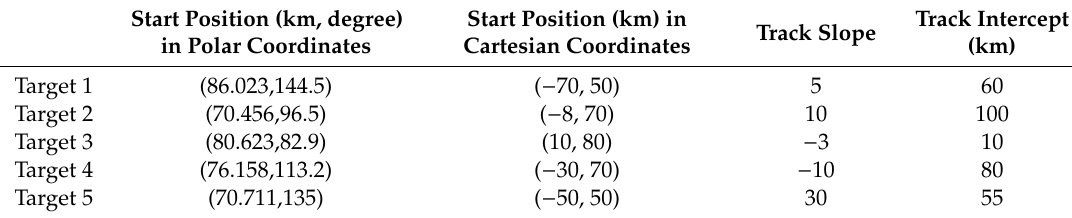
Table 2. The track settings of five targets.